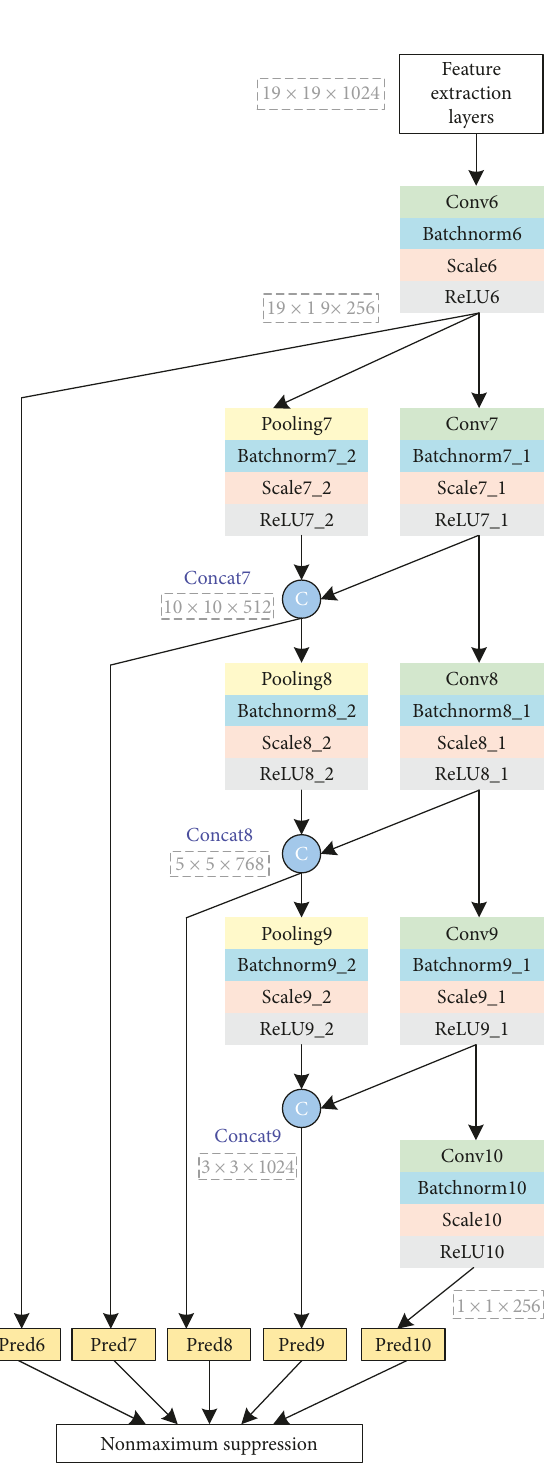
Figure 5: Architecture of multiscale prediction layers with features shared at main